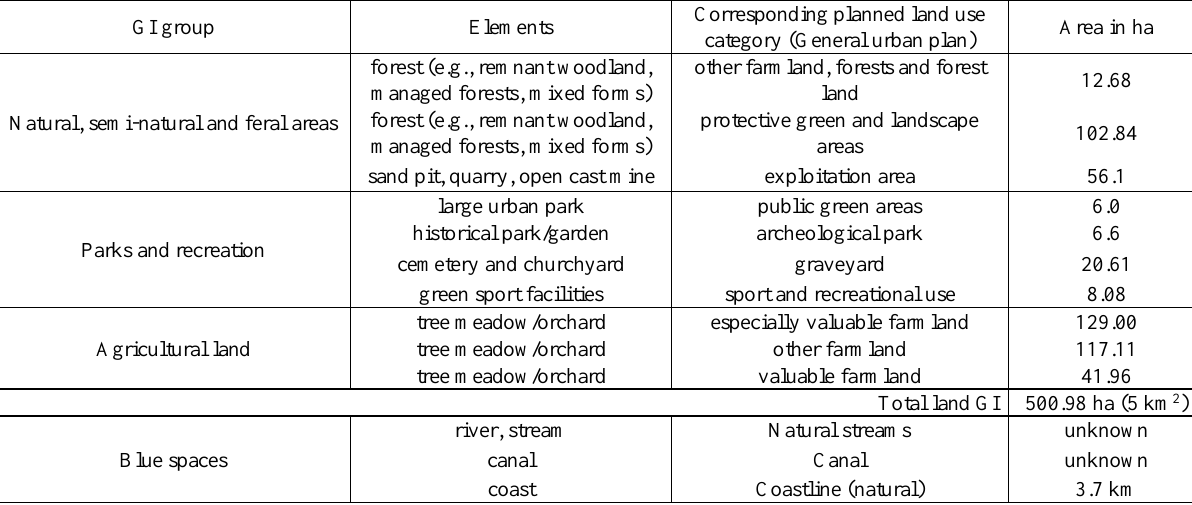
Table 1. Planned land use - mappings to GI